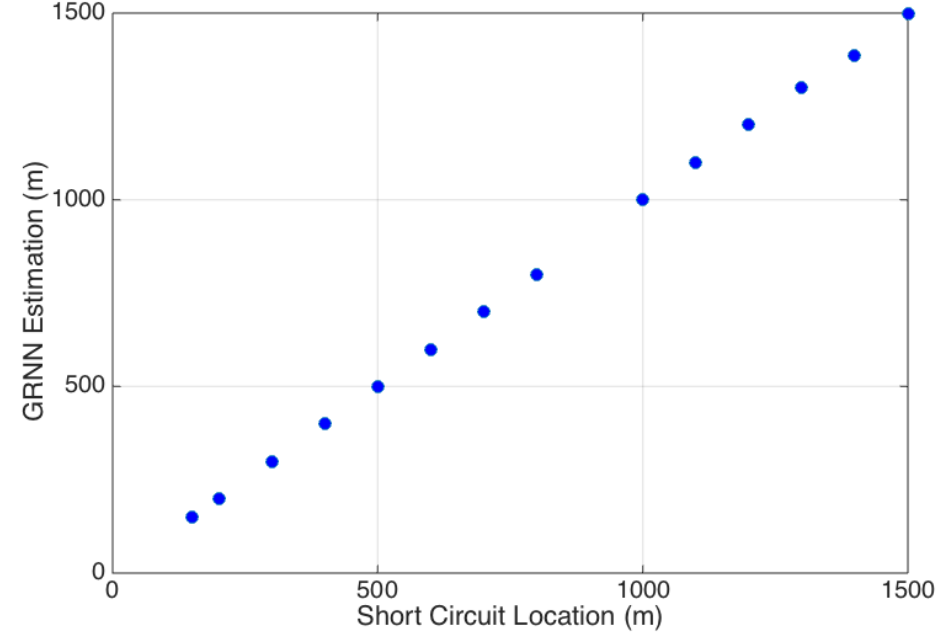
Figure 15. GRNN estimation